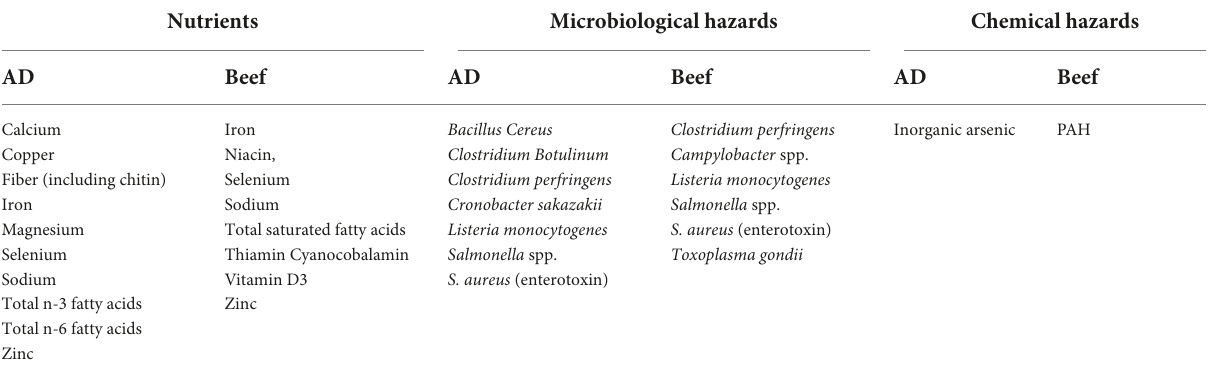
TABLE 3 The “short” list of components identified in minced beef and cricket powder (selection made through the NovRBA case